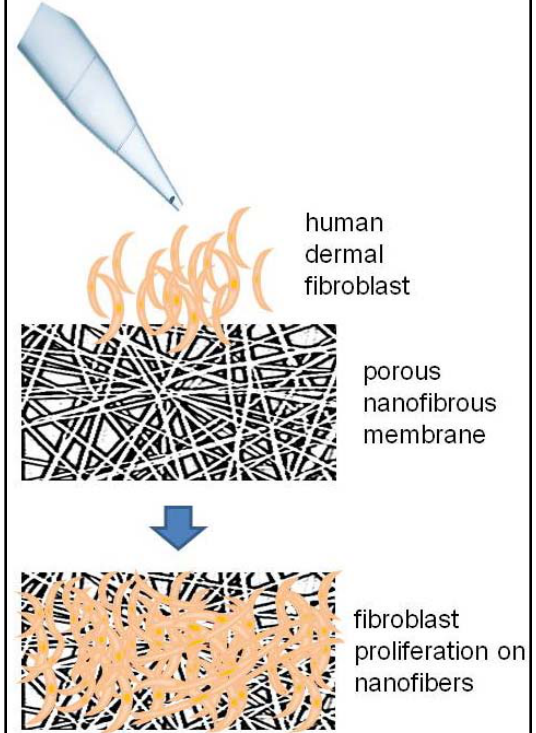
Figure 3. Human dermal fibroblast can be cultured on electrospun nanofibrous membrane to create in vitro allogeneic dermal substitutes.